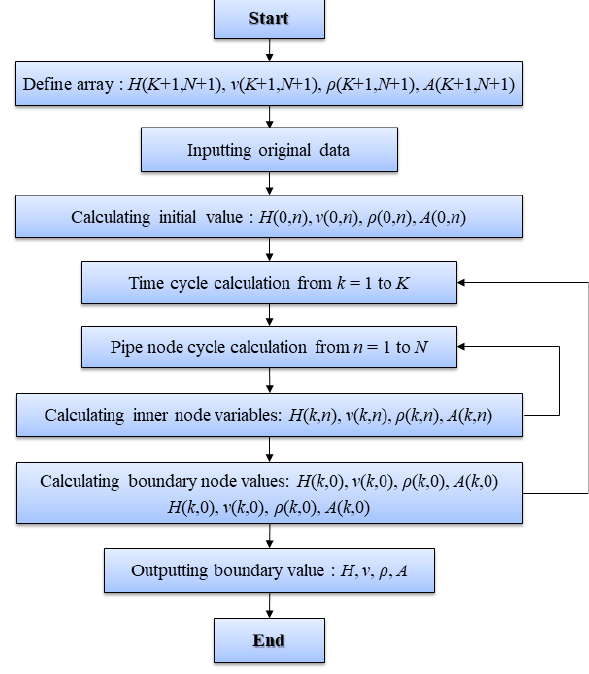
Figure 4. Flowchart of calculation of water hammer four variable closed model.